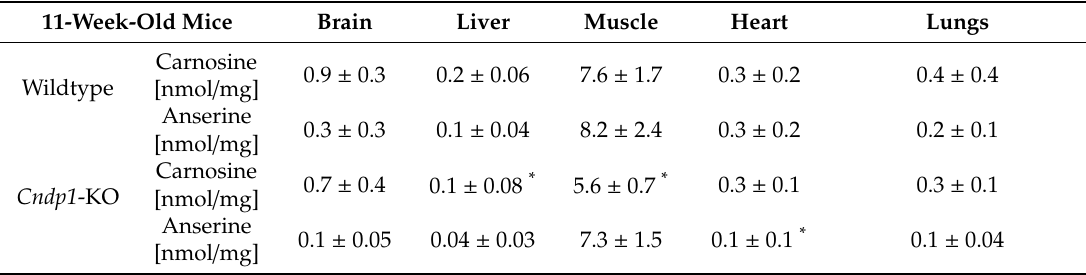
Table 3. Carnosine and anserine concentrations in brain, liver, muscle, heart and lungs of 11-week-old ( n = 8 per group) and 55-week-old Cndp1 -KO and WT mice ( n = 14 per group). No carnosine-degrading activity could be demonstrated in any of the organs. * = significant di ff erences ( p ≤ 0.05) between Cndp1 -KO and WT, # = significant di ff erences ( p ≤ 0.05) between 11 and 55 weeks. 11-Week-Old Mice Brain Liver Muscle Heart Lungs